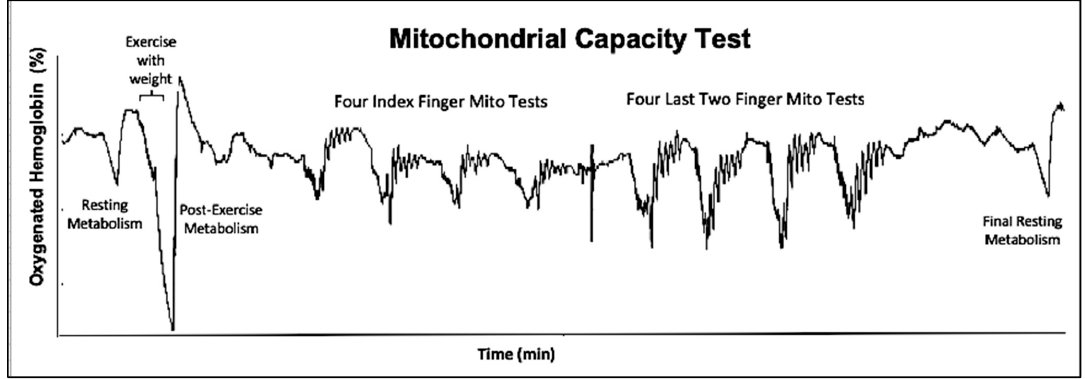
Figure 2. NIRS output produced by the full mitochondrial capacity test. Includes one resting slope, exercise with a weight followed by an exercise cuff, four trials of six cuffs for both the index and last two fingers, and a final resting slope. Slopes decrease over time, indicating that there is recovery of oxygen consumption.